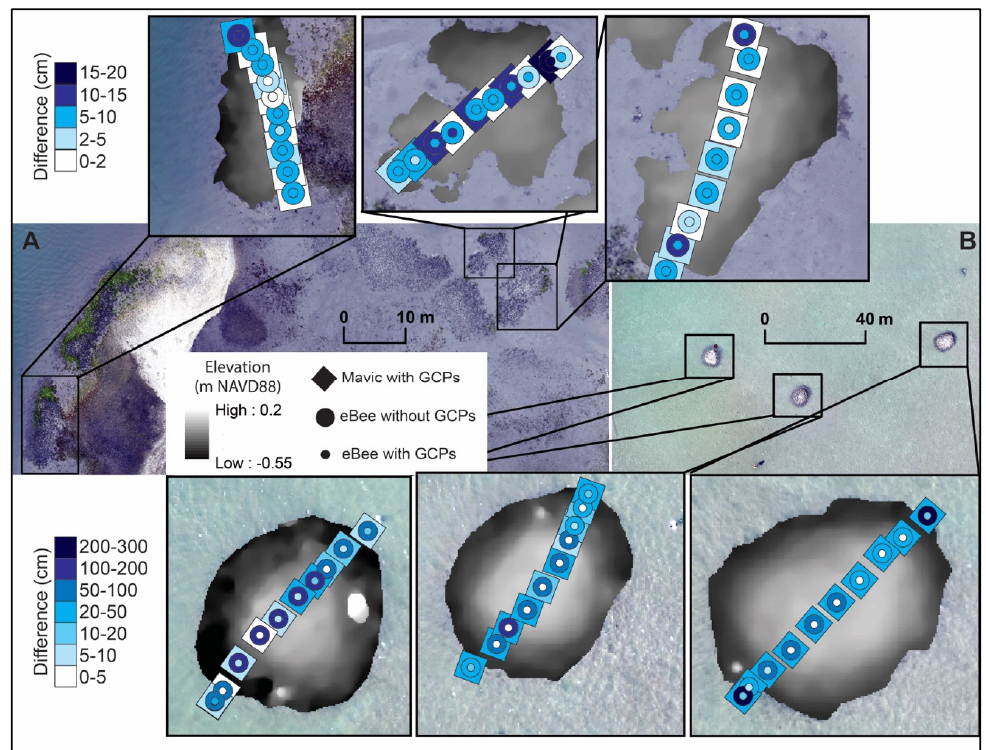
Middle Marsh reefs. The uncorrected eBee imagery showed the highest elevation differences along reef edges at both sites and more overall elevation differences in Middle Marsh. The corrected eBee imagery had improved elevation differences at both sites (Figure 6).